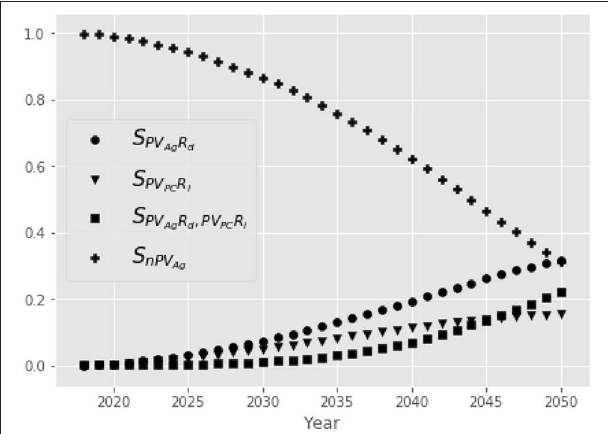
FIGURE 7 | Global sensitivity analysis of the Monte Carlo simulations over 2018–2050 run on 8,192 quasi-random samples. Data have been bootstrapped 1,000 times with replacement. The first-order sensitivity index for (i) silver use in contact metallization are shown (circle) along with (ii) the installed PV power capacity (triangle); (iii) the second-order interaction between these two terms (square) and (iv) silver use in the non-PV sector (plus